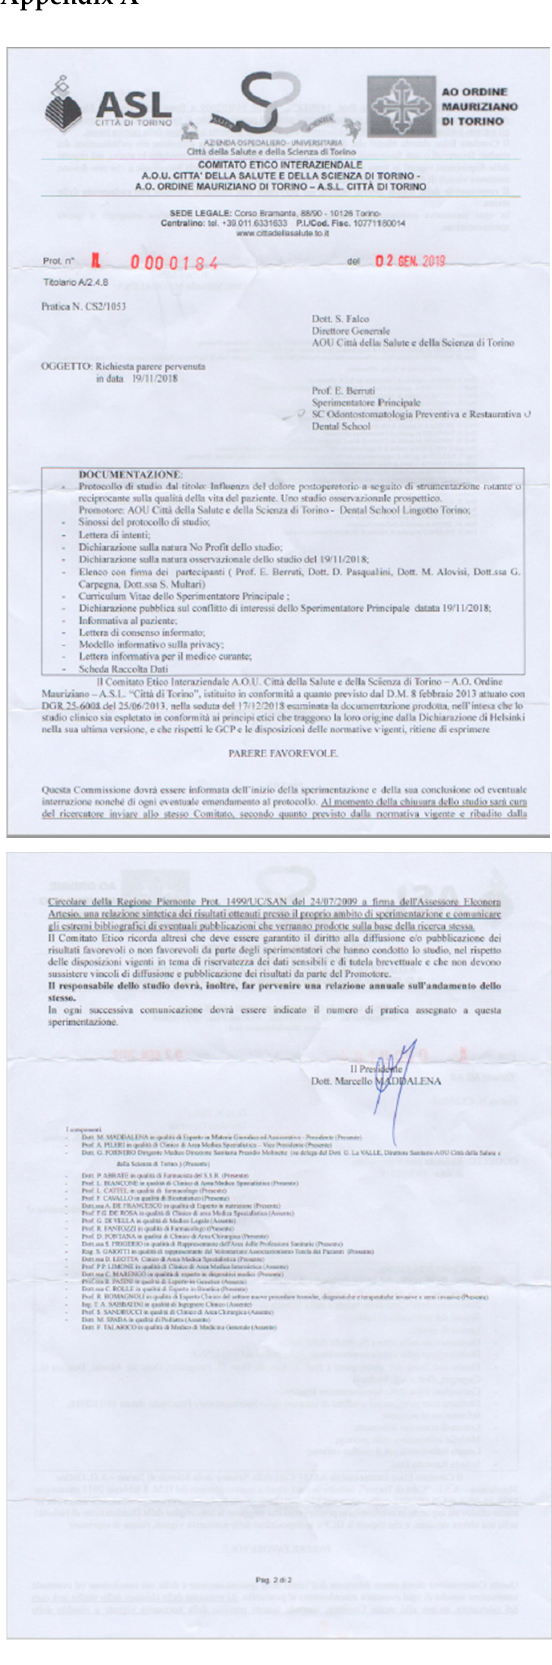
Figure A1. Institutional Review Board Statement.